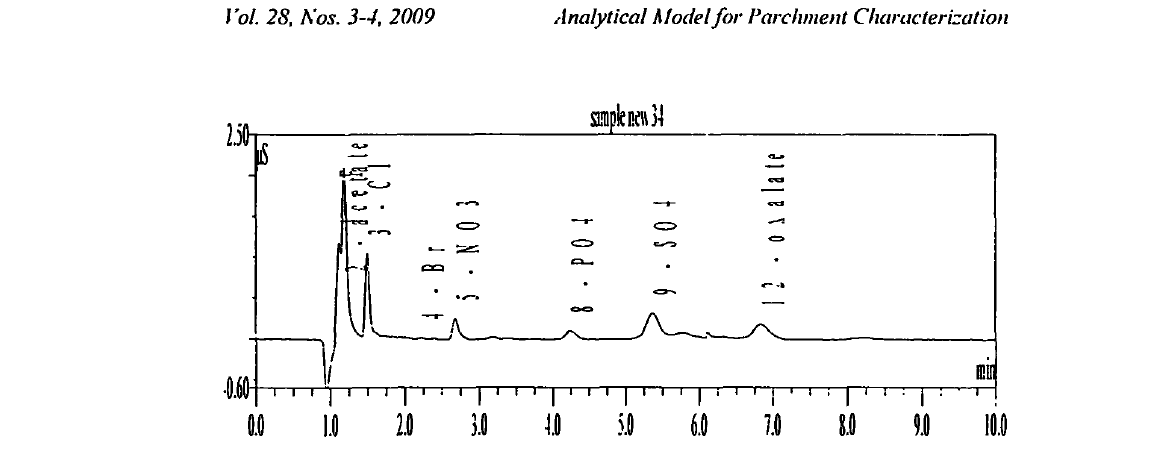
5.0 i.i 7.0 U U 10.0 Separation of anions in solution of modern sample. Conditions: Fig. 63: column, Dionex* lonPac* AS4A-SC, 4 χ 250 mm column, clucnt 1.8 mM Sodium carbonate/ 1.7 mM Sodium bicarbonate eluent and suppressed conductivity detection at self-regenerating mode (applied current 27 mA), injection volume, 25 μι; solutes, 1) fluoride, 2) acetate, 3)chloride, 4)bromide, 5) nitrate, 8) phosphate, 9) sulfate, 12) oxalate.